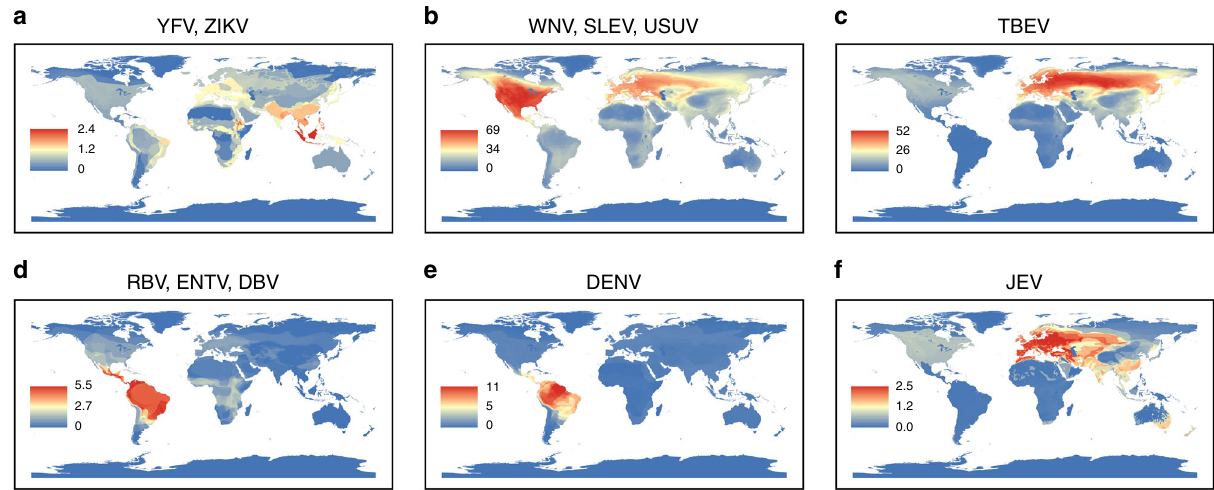
Fig. 4 Geographical distribution of predicted fl aviviral host richness adjusted by the predicted probability. Overlapping geographical ranges accounting for associated probabilities for model predicted hosts in the 95th percentile of probability for each strati fi ed model. a Yellow fever virus (YFV) and Zika virus (ZIKV). b West Nile virus (WNV), St. Louis encephalitis virus (SLEV) and Usutu virus (USUV). c Tick-borne encephalitis virus (TBEV). d Rio Bravo virus (RBV), Entebbe bat virus (ENTV) and Dakar bat virus (DBV). e Dengue virus (DENV). f Japanese encephalitis virus (JEV). Maps were generated using species distribution data from IUCN 12 , and BirdLife International and NatureServe